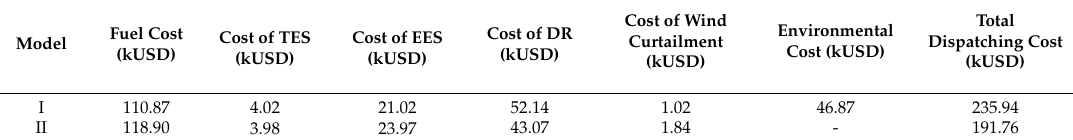
Table 3. Optimized costs of dispatch model I and dispatch model